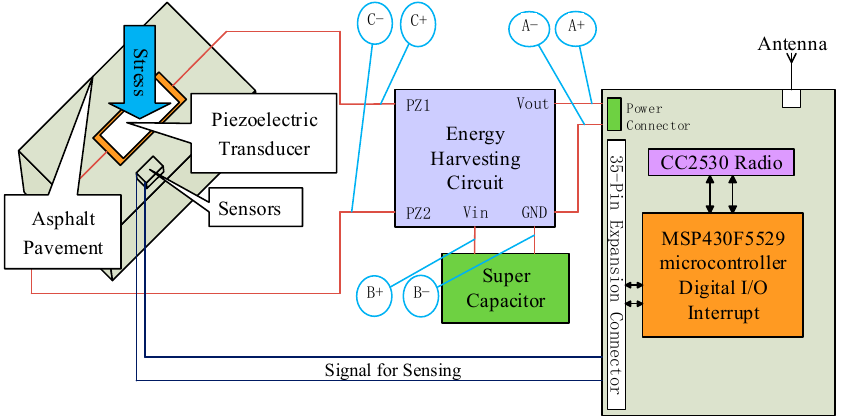
Figure 2. Wireless sensor system for a “smart pavement.”